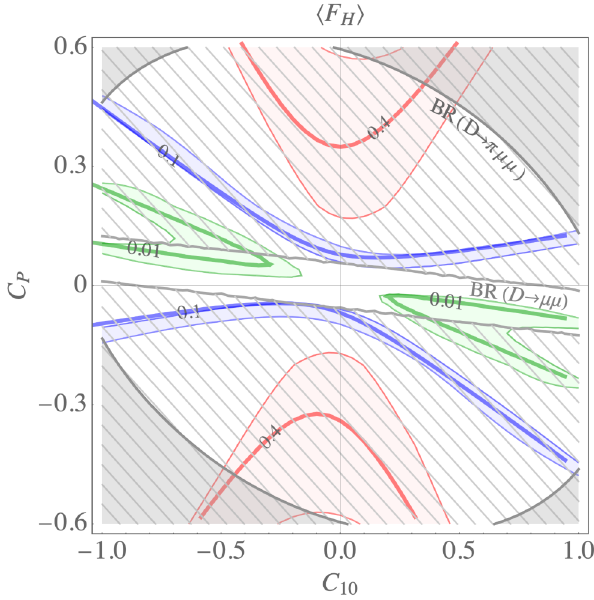
Figure 7 . Contours of the observable h F H i , as defined in the text, in the C 10 – C P plane. The bands around the contours signify the theory uncertainty. The grey lines and shaded areas indicate the exclusion from the LHCb bounds on the branching ratios B ( D 0 → µ + µ − ) [52] and B ( D + → π + µ + µ − ) [38] as labelled.